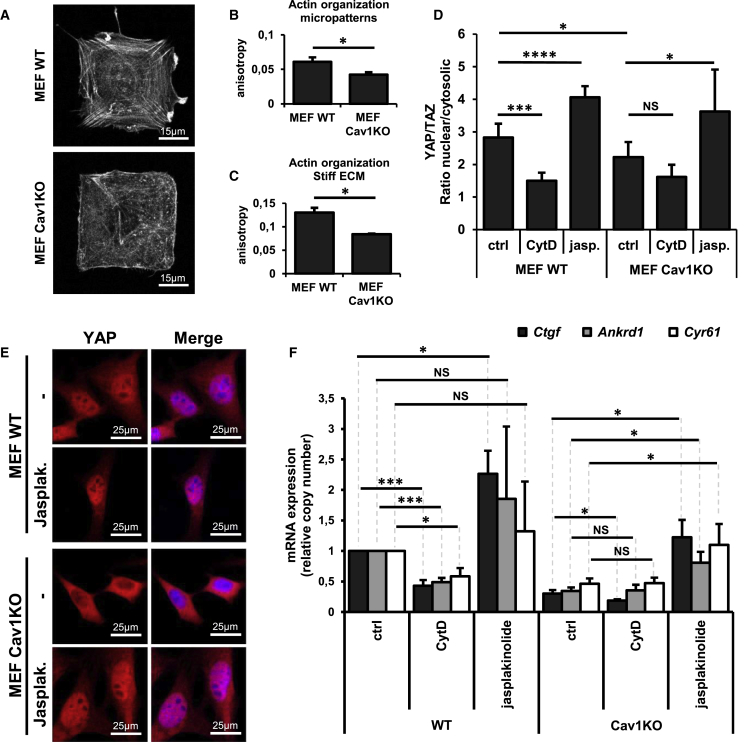
YAP Activity Defects in Cav1KO MEFs Are a Consequence of Defective Actin Polymerization(A) Confocal immunofluorescence images showing actin distribution in cells plated on large squared micropatterns (2,025 μm2). Actin was detected by staining with fluorophore-conjugated phalloidin.(B and C) Quantification of actin-fiber anisotropy (fiber order/organization) in WT and Cav1KO MEFs growing on squared micropatterns (n = 7–10; B) or on a stiff ECM (n = 3; C).(D) ImageJ quantification of YAP subcellular distribution in cells treated for 24 hr with 1 μM CytD, 0.05 μM jasplakinolide (Jasplak), or DMSO. Data were obtained from 3 to 8 independent experiments and are presented as means ± SD; ∗p < 0.05, ∗∗∗p < 0.005, and ∗∗∗∗p < 0.0005.(E) Confocal immunofluorescence of YAP in cells grown for 24 hr in the presence of 0.05 μM jasplakinolide or DMSO. Nuclei were detected with Hoechst (blue).(F) qRT-PCR of YAP target genes in MEFs treated for 24 hr with 1 μM CytD, 0.05 μM jasplakinolide, or DMSO (control). Data from jasplakinolide experiments (n = 5) and CytD experiments (n = 3) were normalized to WT controls. Data represent means ± SEM; ∗p < 0.05.See also Figure S3.